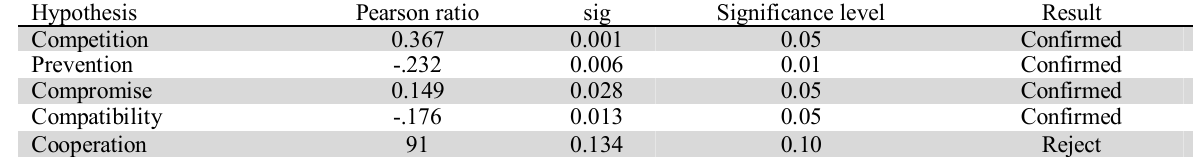
The summary of testing the relationship between conflict management and brand promise